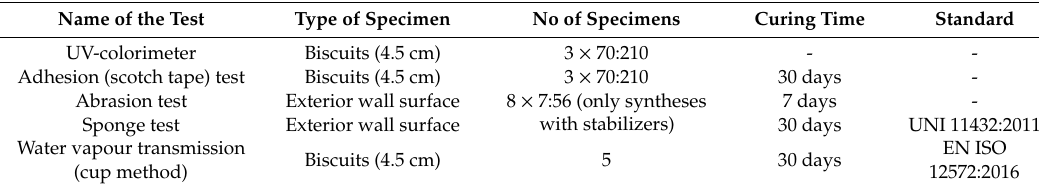
Table 4. Laboratory analyses for developed